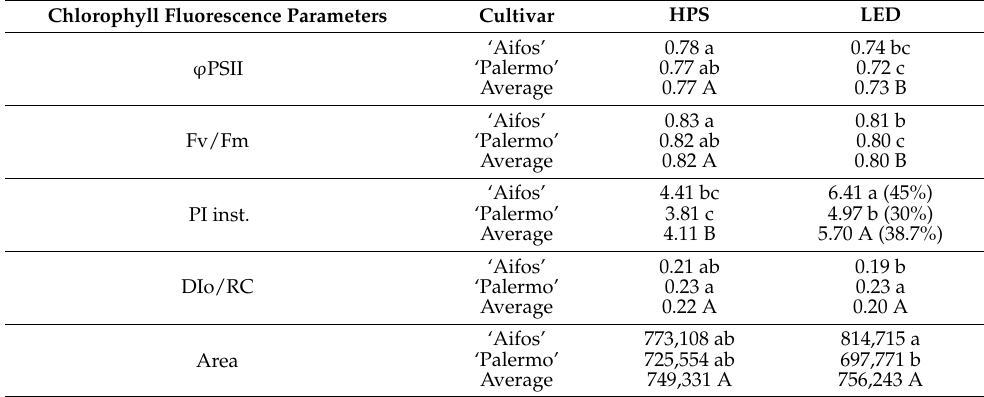
Table 1. Effects of supplementary lighting with sodium and LED lamps on the photosynthetic activity of pepper seedling leaves according to the cultivar (averages of four measurement